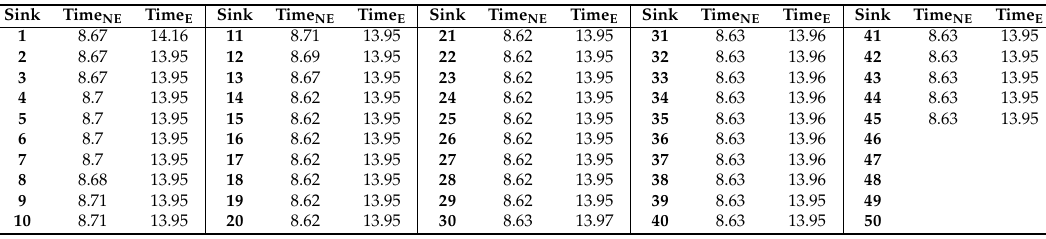
Table 5. Scenario 2: transmission times (in s) for each sink all over the transmission line. (Distance between poles is equal to 100 m, κ = 45, η = 1, NE means no encryption, E means